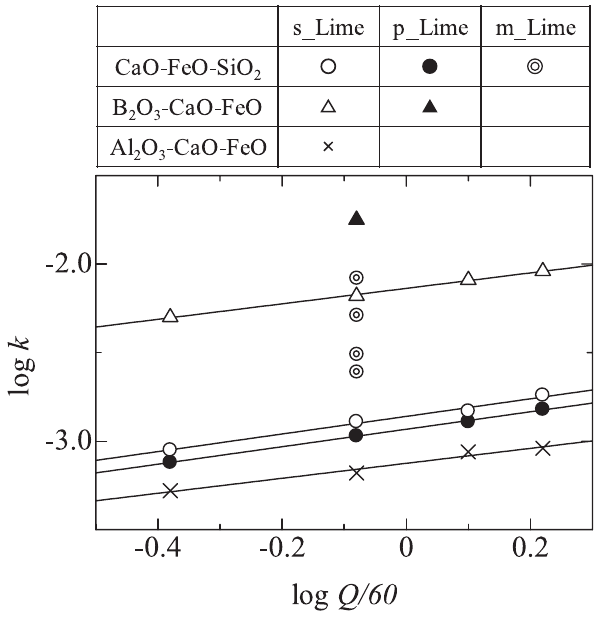
Fig. 20: Comparison of experimental k and calculated k